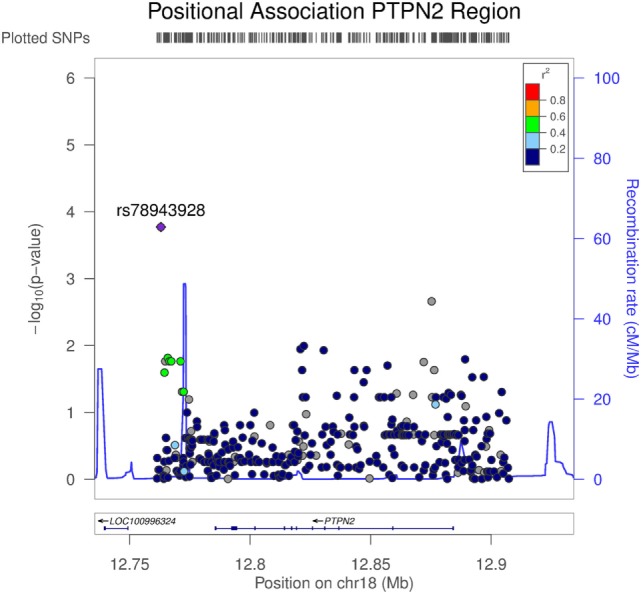
Association of variants in PTPN2 with tumor necrosis factor alpha-induced protein 3 (TNFAIP3) protein expression in axial spondyloarthritis (AxSpA) subjects. The region covering PTPN2 spanned approximately 146 kbp. Variants were determined from targeted next-generation sequencing (NGS) and the high-quality variants used in this analysis totaled 364. p Values testing the correlation of each genetic variant in the PTPN2 region with normalized TNFAIP3 levels within the AxSpA subjects were generated by LocusZoom (http://csg.sph.umich.edu/locuszoom/). The statistical approach used a linear regression model adjusted for age and sex. Linkage disequilibrium (r2) between the variant exhibiting the highest level of significance and the linked variants is denoted by color. Additionally, estimated recombination rate across the region is shown.